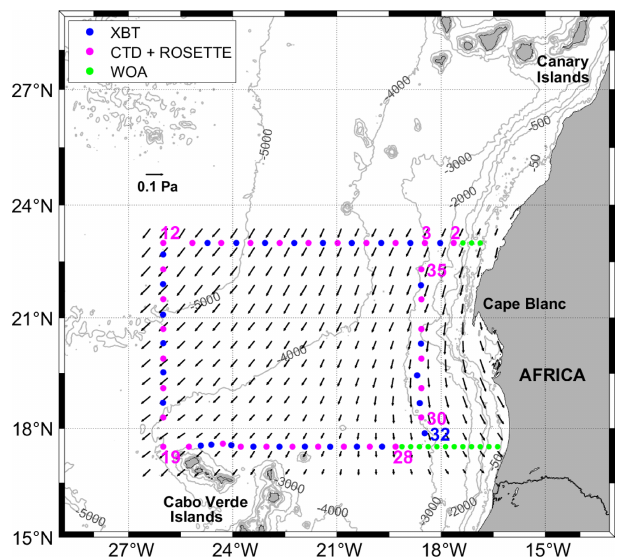
Figure 1. CTD rosette sampling stations (pink dots) and XBT sam- ple locations (blue dots) during the FLUXES-I cruise. WOA sta- tions are represented by green dots. Time-averaged wind stress dur- ing the cruise is also represented, with the inset arrow denoting the scale (shown with half of the original spatial